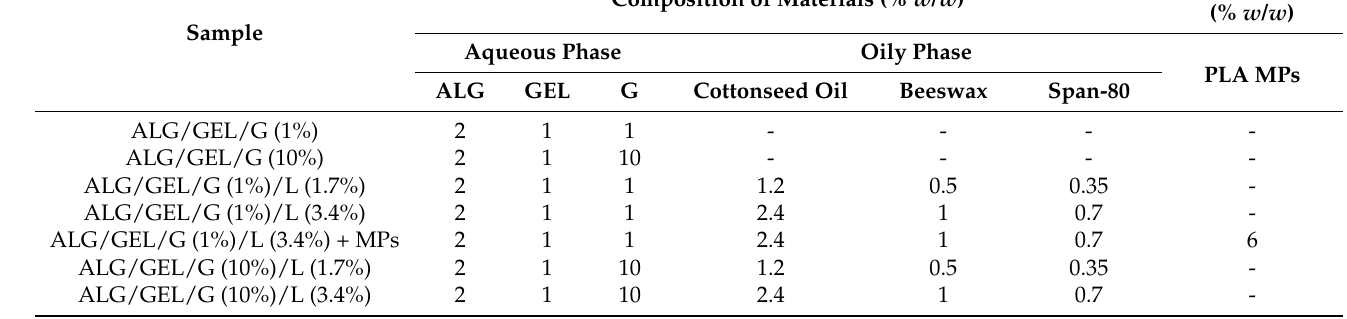
Table 1. The types of prepared materials composed of sodium alginate (ALG), gelatin (GEL), glycerol (G), and different amount of lipids (L): cottonseed oil, beeswax, and emulsifier Span-80, as well as the sample containing polylactide microparticles (PLA